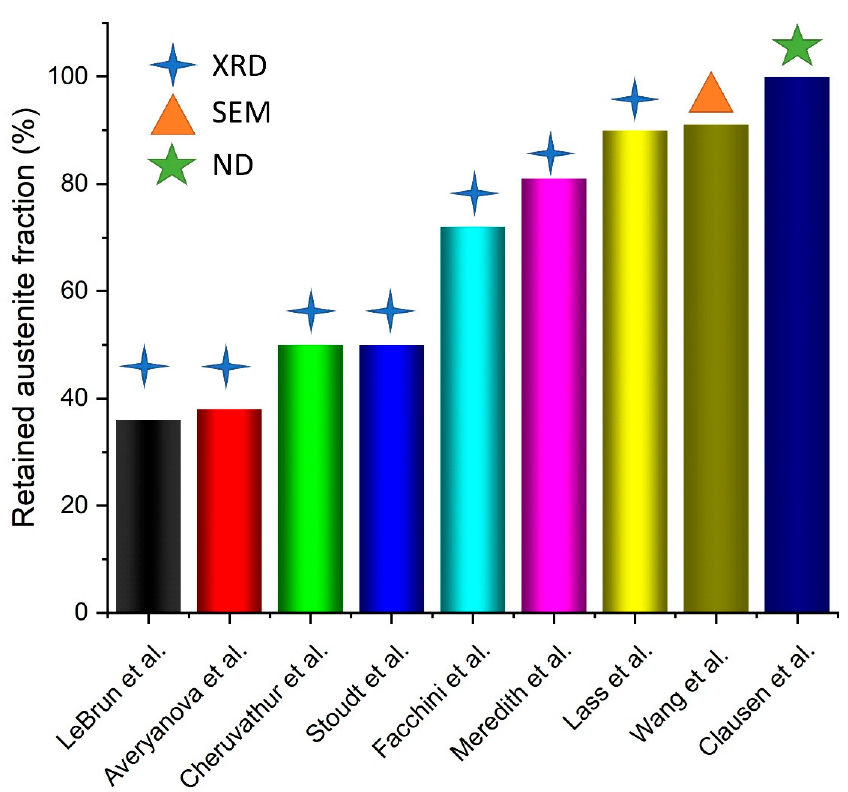
Figure 1. An incomplete set of phase fraction of retained austenite in as-built 17-4 steel, identified in literature. The measurement technique is specified by the symbols on the top of the individual columns. XRD stands for XRD results acquired using in-house X-ray diffractometer. SEM results are acquired from EBSD. ND stands for neutron diffraction.